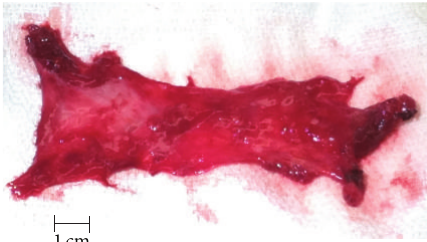
Figure 3: Tissue removed from the patient’s right shoulder during the scapulothoracic bursectomy